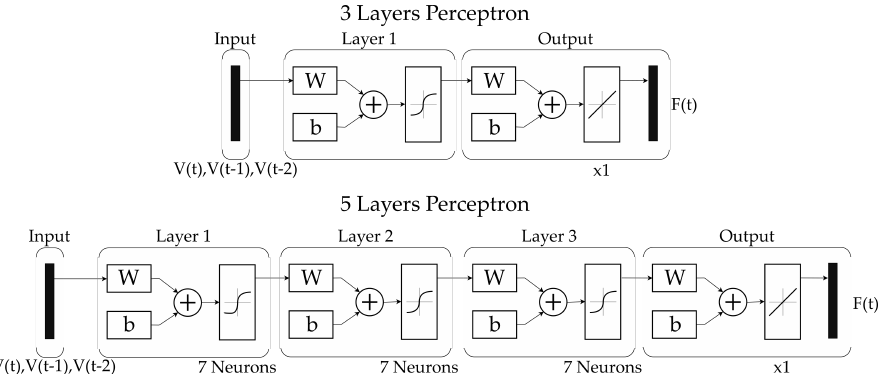
Figure 8. Schematic view of both 3 and 5-layer perceptrons used to model the hysteretic behaviour of the sensor. Both neural networks feature three inputs corresponding to the actual sensor voltage and the two previous values; hidden layers of seven neurons and an output layer that returns a single value, corresponding to the estimated force